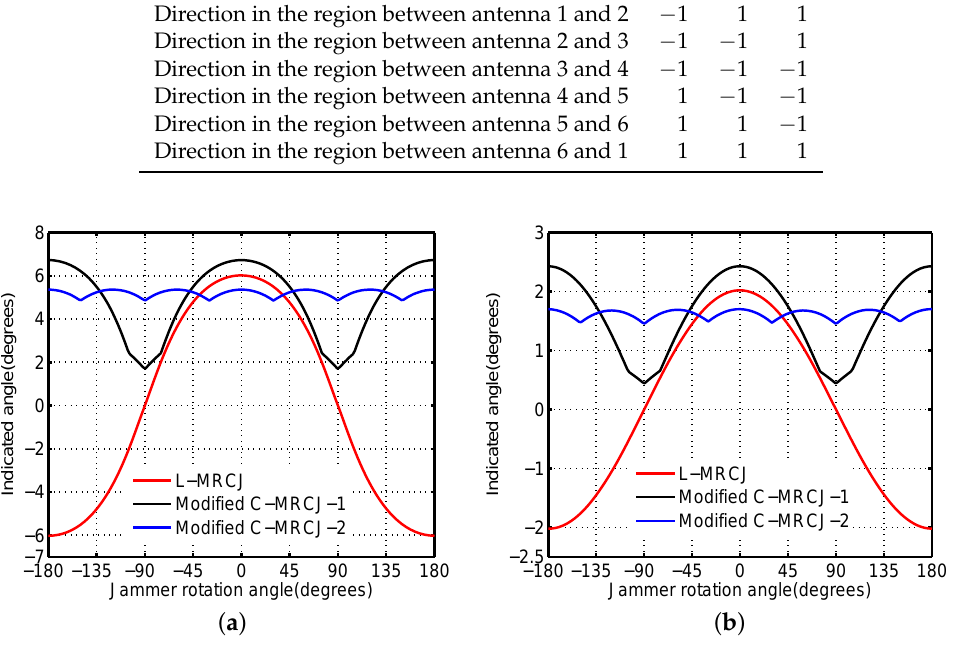
Figure 10. Monopulse-indicated angles of L-MRCJ and modified C-MRCJ when the jammer antennas rotate. ( a ) The system parameters are a 1 = a 2 = a 3 = − 0.5 dB, φ 1 = φ 2 = φ 3 = 180 ◦ . ( b ) The system parameters are a 1 = − 0.5 dB, a 2 = − 1.5 dB, a 3 = − 2.5 dB, φ 1 = 170 ◦ , φ 2 = 175 ◦ , φ 3 = 180 ◦